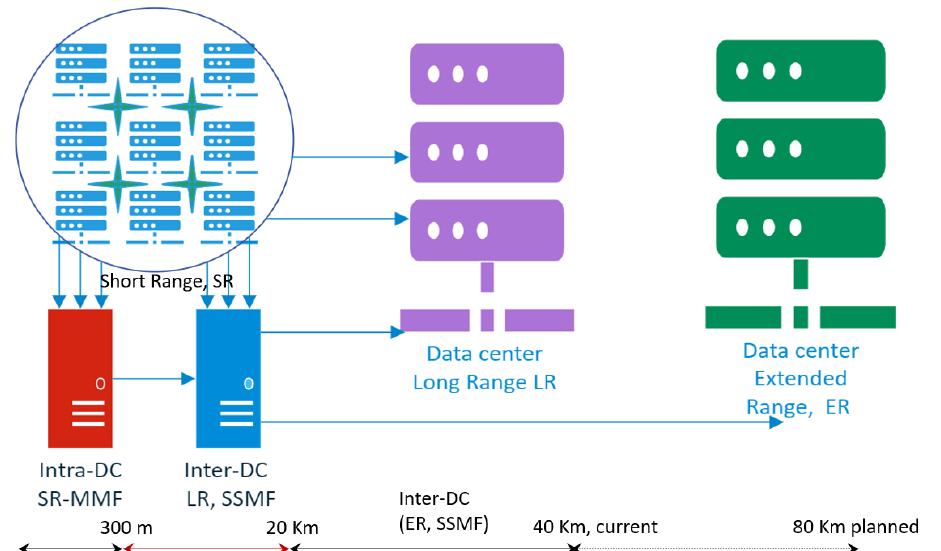
Figure 3. The length scales and potential applications of short-reach optical communications. SR: short-reach, MMF: multimode fiber, SSMF: standard single mode fiber, LR: long range, ER: ex- tended